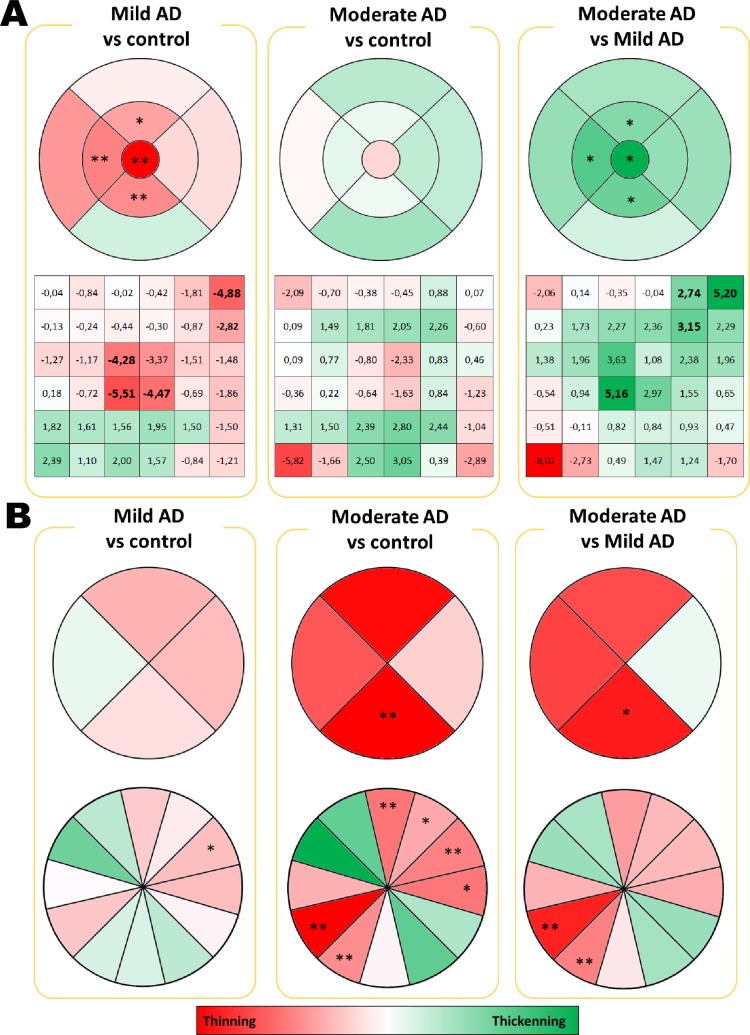
Colorimetric percentage differences of retinal thickness between groups.(A) Macular OCT. Upper: OCT concentric circular rings. Bottom: 6x6 mm rectangular grid, (B) Peripapillary OCT. Upper: Four peripapillary quadrants. Bottom: 12-o’clock hour position segmentation. In red, thickness decrease; in green thickening. In bold: *P < 0.05. **P < 0.01. Mann-Whitney U test.